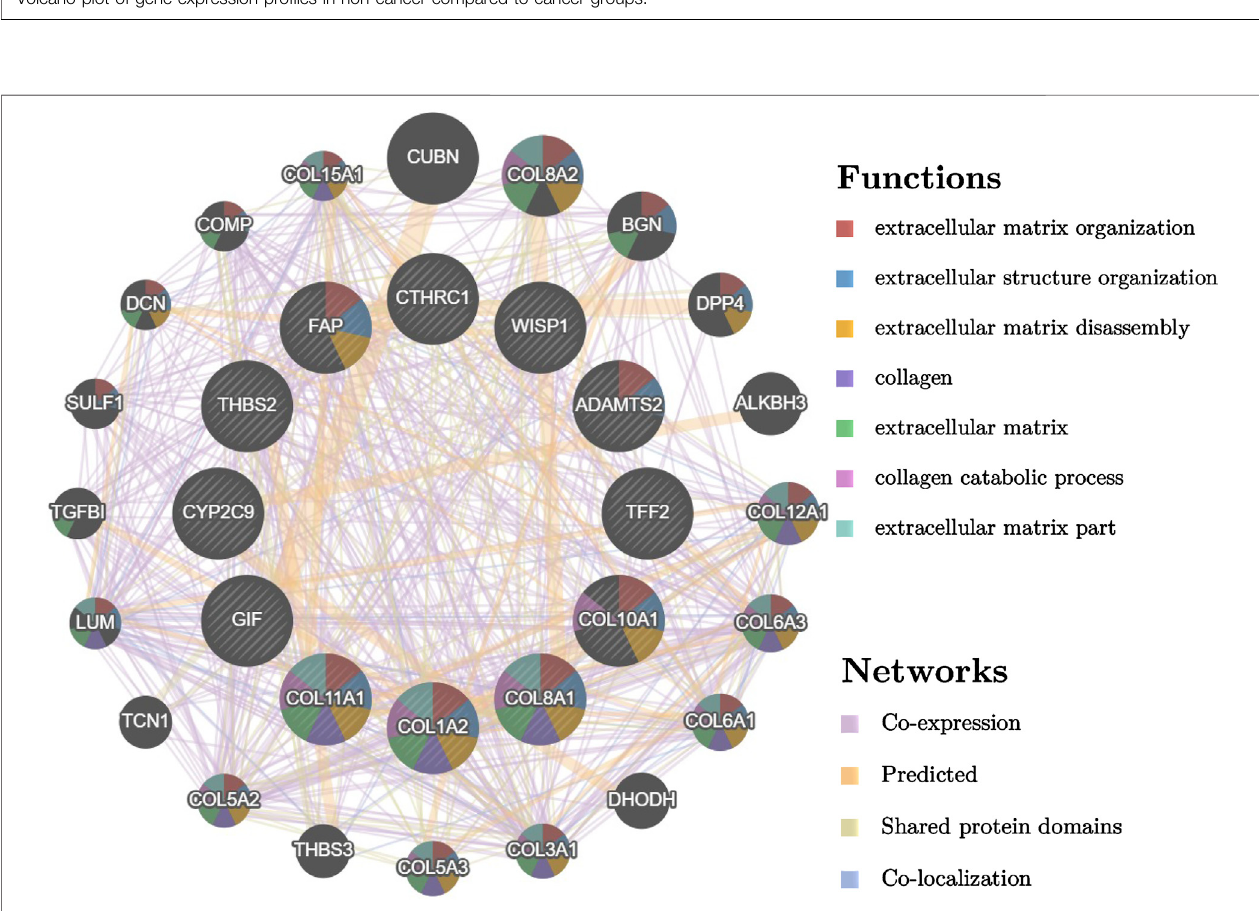
FIGURE 2 | PPI network of different expressed hub genes and their interactors visualized by GeneMANIA.